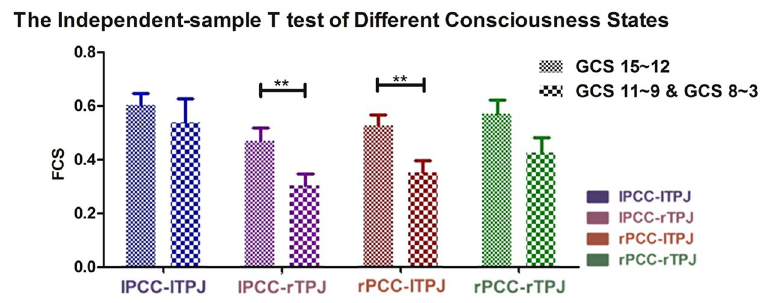
Figure 3. Differences in the PCC-TPJ FCSs between the low/medium and high GCS subgroups of patients (low/medium GCS: 9 patients, high GCS: 11 patients) using an independent group analysis. The bars represent the relative magnitudes of the FCSs (mean + / − SE). Low/medium GCS versus high GCS: lPCC-lTPJ (F = 3.932; P = 0.126); lPCC-rTPJ (F = 0.607; P = 0.002 < 0.01); rPCC-lTPJ (F = 0.008; P = 0.004 < 0.01); rPCC- rTPJ (F = 0.072; P = 0.315). The cross-hemispherical FCSs represented the major difference between the low/ medium GCS and high GCS groups. ** . α = 0.01; * . α =